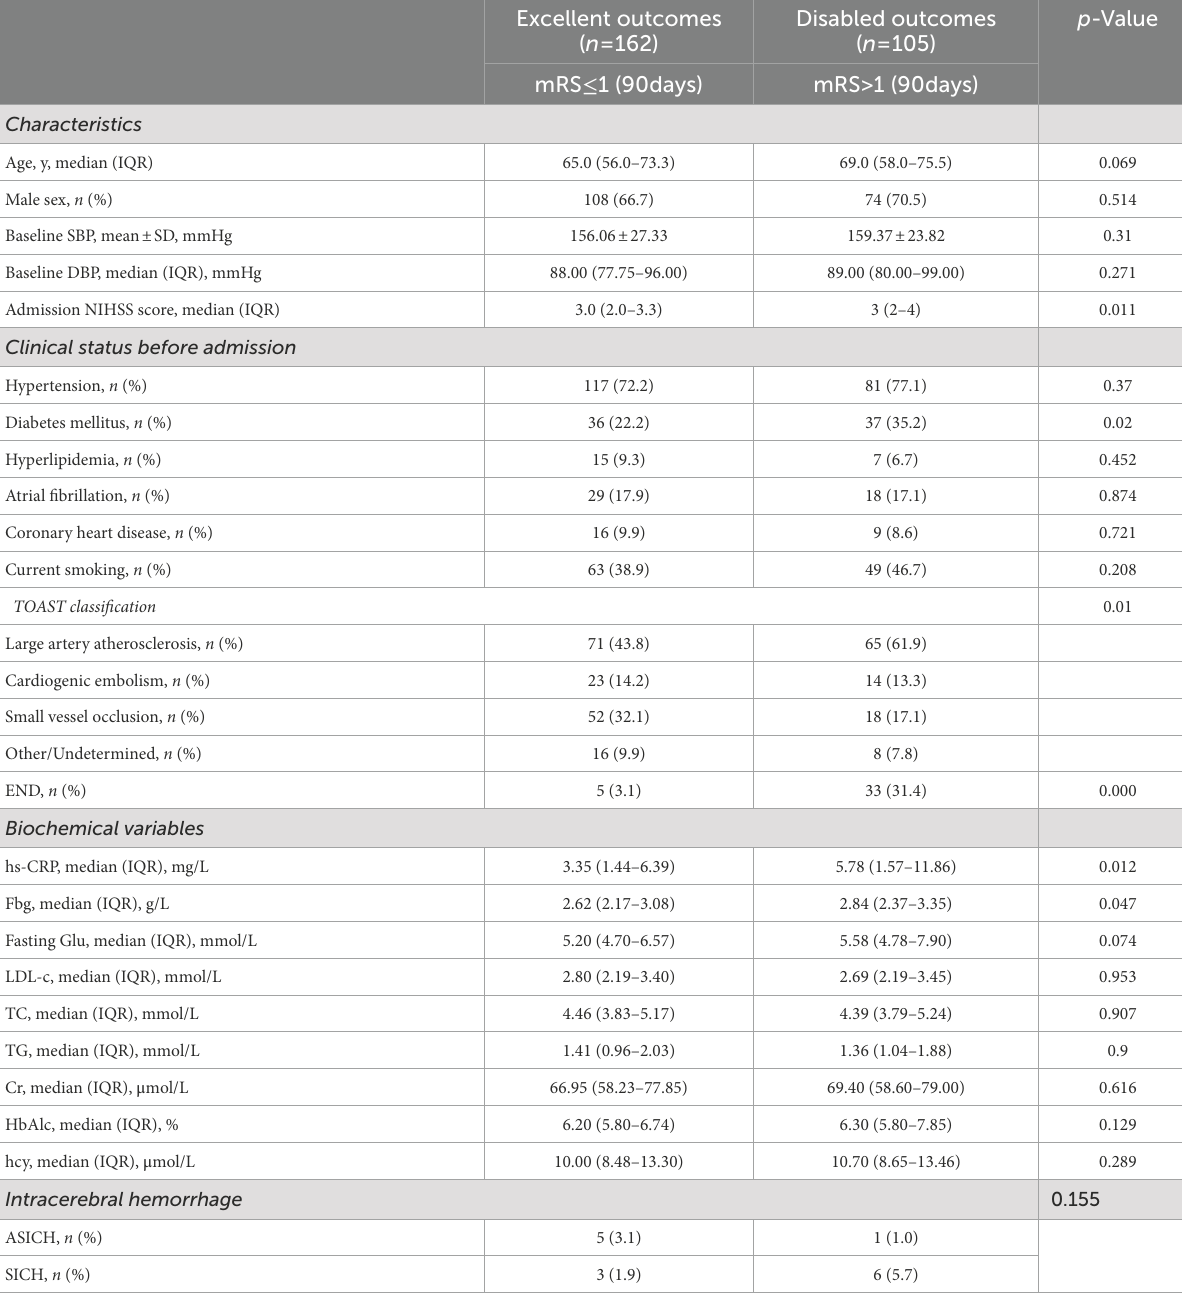
TABLE 2 Baseline clinical and biochemical characteristics, stratified for functional